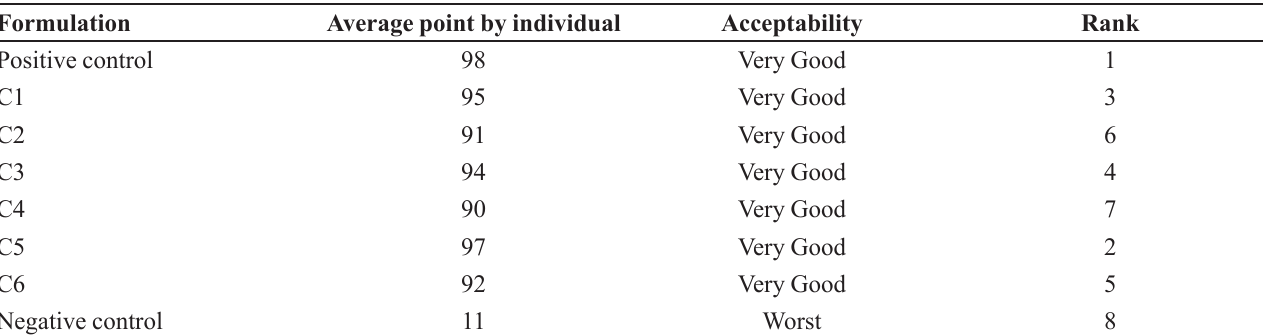
TABLE V - Summary report of taste evaluation study report Formulation